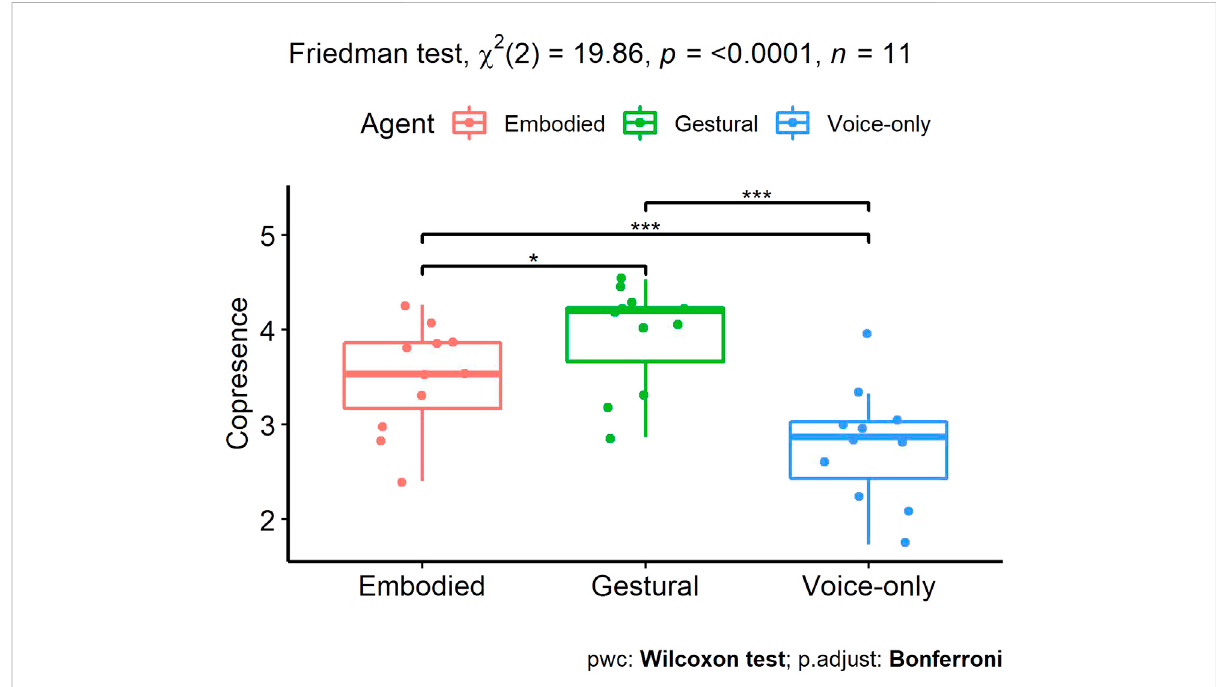
FIGURE 6 Results of the Copresence questionnaire (5-point Likert Scale from 1 to 5; Statistical signi fi cance: *( p < 0.05), *** ( p <